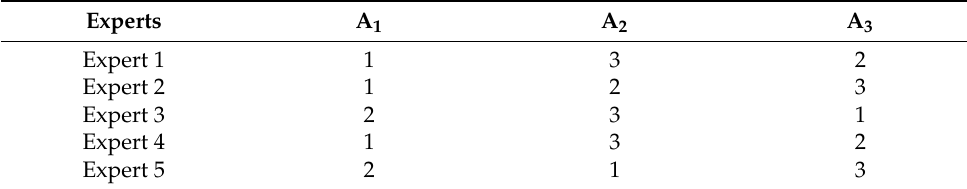
Table 1. Expert ranking table of importance of first-level indicators. Experts A 1 A 2 A 3 Expert 1 1 3 2 Expert 2 1 2 3 Expert 3 2 3 1 Expert 4